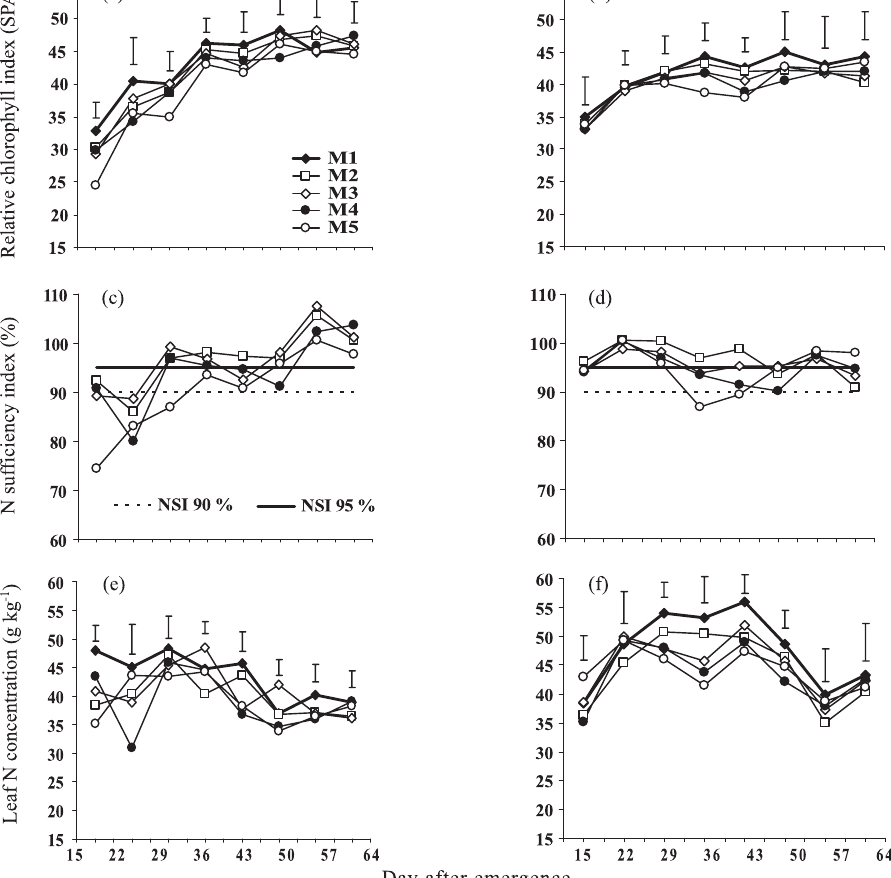
figure 1. relative chlorophyll index (a) and (b), N sufficiency index (c) and (d) and leaf N concentration (e) and (f) in common bean cv. Perola, at different stages of evaluation as affected by N sidedressing management in the rainy and dry growing seasons. m1: 40 + 80 + 80 kg ha -1 , m2: 20 + 40 + 40 kg ha -1 , m3: 20 kg ha -1 N at sowing + 30 kg ha -1 when chlorophyll readings indicated NSi<95 %; m4: 20 kg ha -1 N at sowing + 30 kg ha -1 when chlorophyll readings indicated NSi<90 and m5: control, without N application. Vertical bars represent lSd by the Tukey test as 5